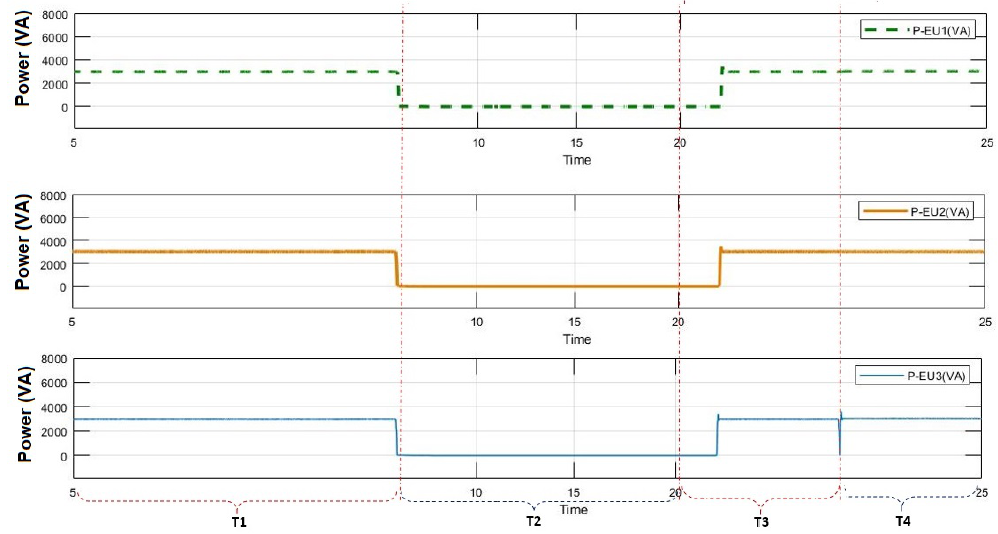
Figure 11. Voltage and Apparent Power graphs (Three-Phases signals) measured at the secondary output of the Distribution Transformer.